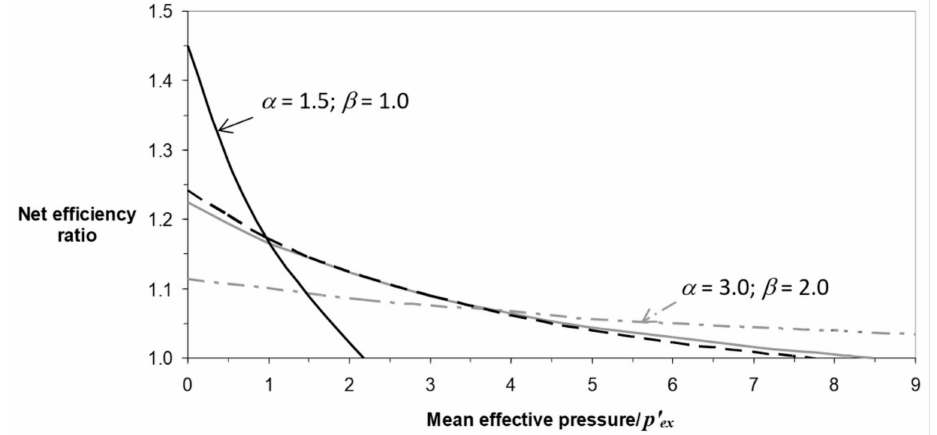
Figure 6. The ratio of net efficiency for partial load cycles reducing r e ≤ r = 8.5 over reducing r in ≤ 1.0, for the same mean effective pressure and cycles with constant γ and γ b . Continuous lines are for α = 1.5, and dash lines for α = 3.0. Black lines are for β = 1.0, and gray lines for β = 2.0. The remaining parameters are of the same value as in Figure